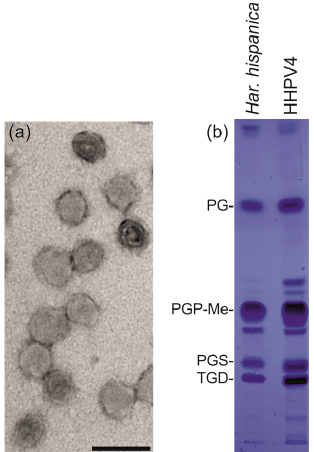
Figure 4. HHPV4 virion and its lipids. ( a ) Transmission electron microscopy (TEM) micrograph of the 2 × purified HHPV4 particles negatively stained with 1% ammonium molybdate. Scale bar equals 100 nm; ( b ) Thin-layer chromatogram of lipids extracted from H. hispanica cells and 2 × purified HHPV4 particles.